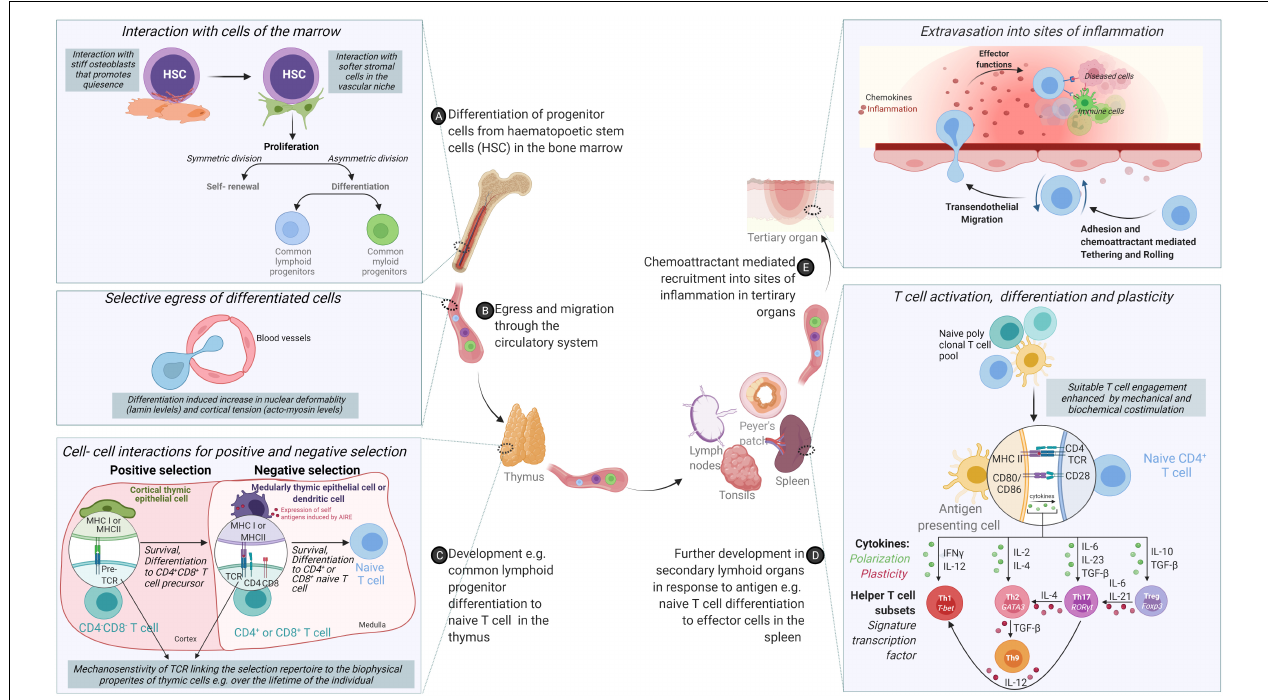
FIGURE 1 | From origin to function – an odyssey to the battlefront guided through cooperation and tested by competition . (A) Cells of the immune system originate from hematopoietic stem cells (HSCs) in the bone marrow via differentiation cues received from the mechanical and chemical composition of the bone marrow. (B) Following differentiation, acquisition of migratory behavior enables cells to egress the bone marrow and circulate through the body via lymphatic and circulatory systems. (C) While some cells of the innate immune system compartment complete their differentiation in the bone marrow, adaptive cells such as T cells need comprehensive training in self- non-self-discrimination before acquisition of effector molecules through positive and negative selection in secondary lymphoid organs. (D) Differentiated immune cells colonize different organs in the body or continue circulating. (E) Functional immune cells are called upon to sites of inflammation to control infection or determine the magnitude and nature of immune